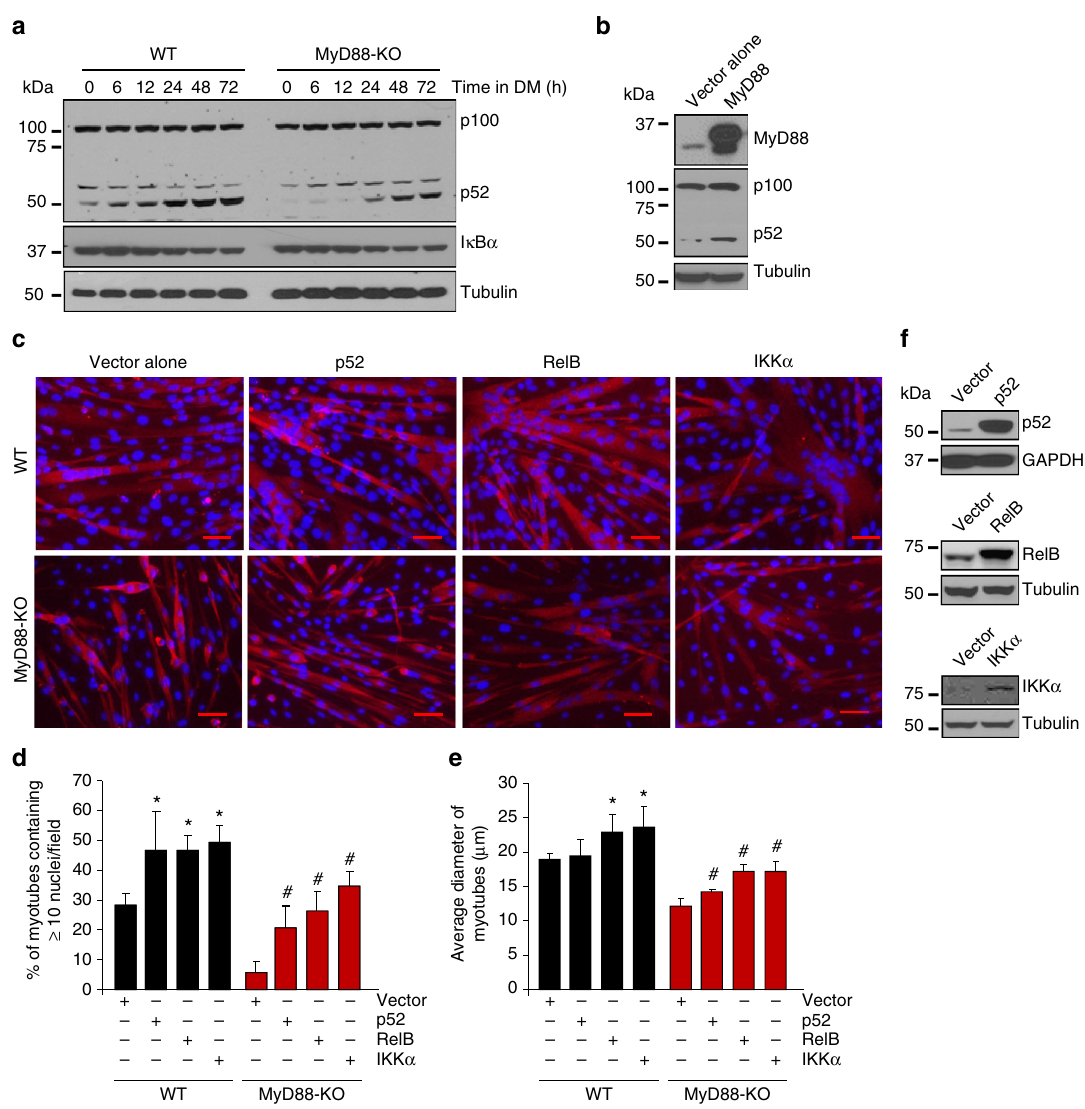
Fig. 4 MyD88 regulates myoblast fusion through non-canonical NF- κ B pathway. a Primary myoblasts were prepared from hind limb muscle of WT and MyD88-KO mice. Cells were then plated at equal densities and incubated in DM. Samples were collected at various time points following addition of DM and processed for biochemical analysis. Immunoblots demonstrate the levels of p100/p52, I κ B α , and unrelated protein tubulin. b Primary myoblasts prepared from WT mice were transfected with empty vector or vector containing MyD88 cDNA. After 48 h, cells were collected and protein lysates were made. Representative immunoblots demonstrating levels of MyD88, p100/p52, and unrelated protein tubulin. c WT and MyD88-KO primary myoblasts were transfected with vector alone or vector containing cDNA for p52, RelB, or IKK α . The cells were incubated in DM for 48 h and cultures were fi xed and stained with anti-MyHC and DAPI. Representative photomicrographs are presented here. Scale bar: 50 µ m. d Quanti fi cation of the percentage of myotubes containing ≥ 10 nuclei under each condition. e Quantitative analysis of average myotube diameter under indicated condition. For d and e , N = 5 in each group. Error bars represent s.d. * p < 0.05 from WT cultures transfected with vector alone by unpaired t -test. # p < 0.05 from MyD88 cultures transfected with vector alone by unpaired t -test. f Representative immunoblots presented here con fi rm the overexpression of p52, RelB, and IKK α proteins